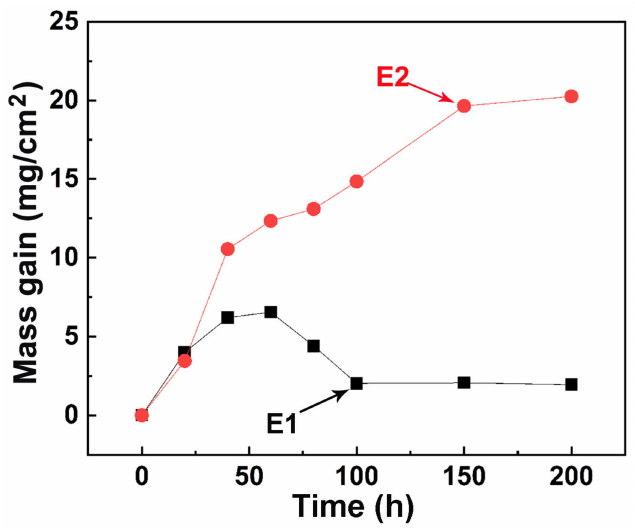
Figure 3. Corrosion kinetics curves of samples E1 and E2 during the corrosion experiments.